Question: Looking at the figure, what chart type is it?
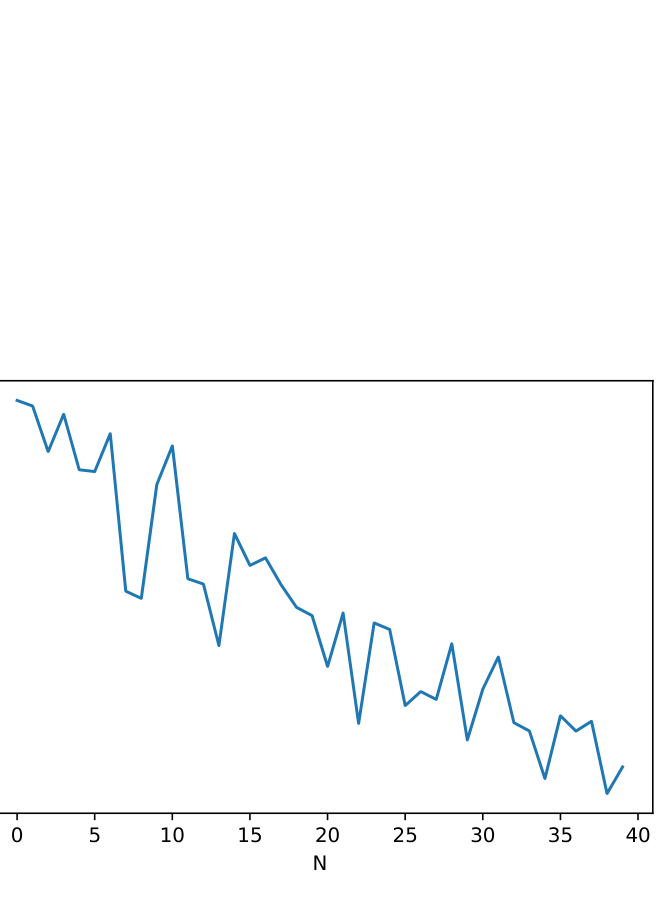
Answer: line